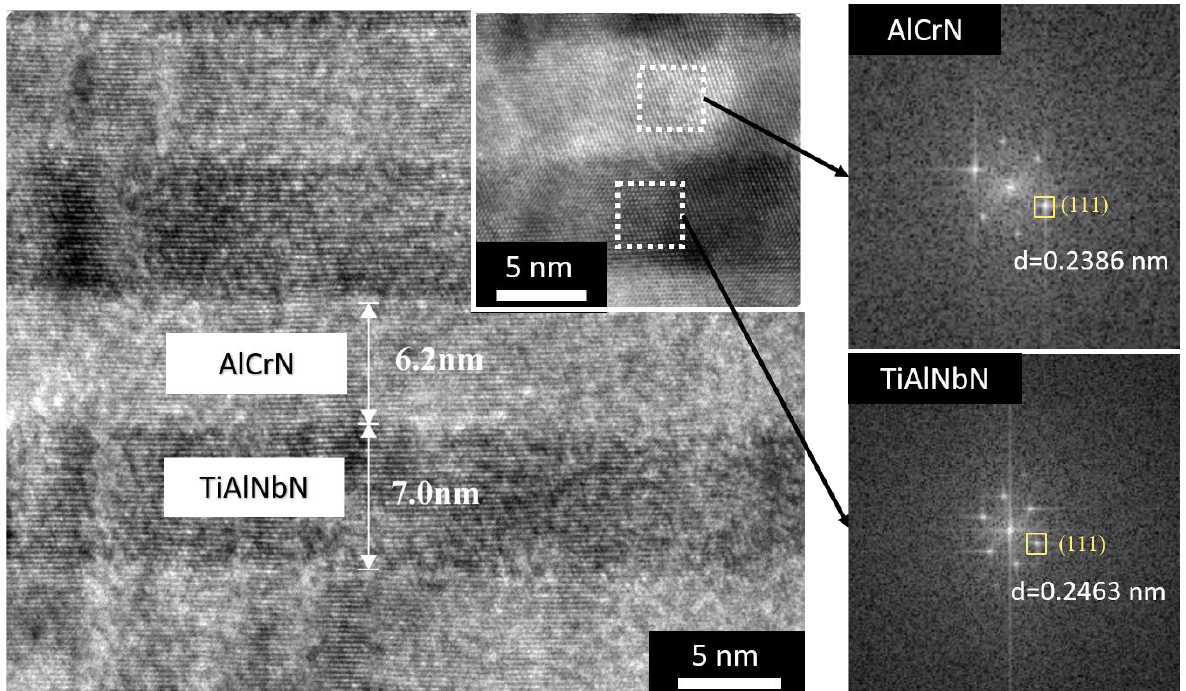
Figure 5. High magnification cross-sectional HRTEM micrograph of the top TiAlNbN/AlCrN coating ( left ) and corresponding FFT images ( right ) of each AlCrN and TiAlNbN layers.